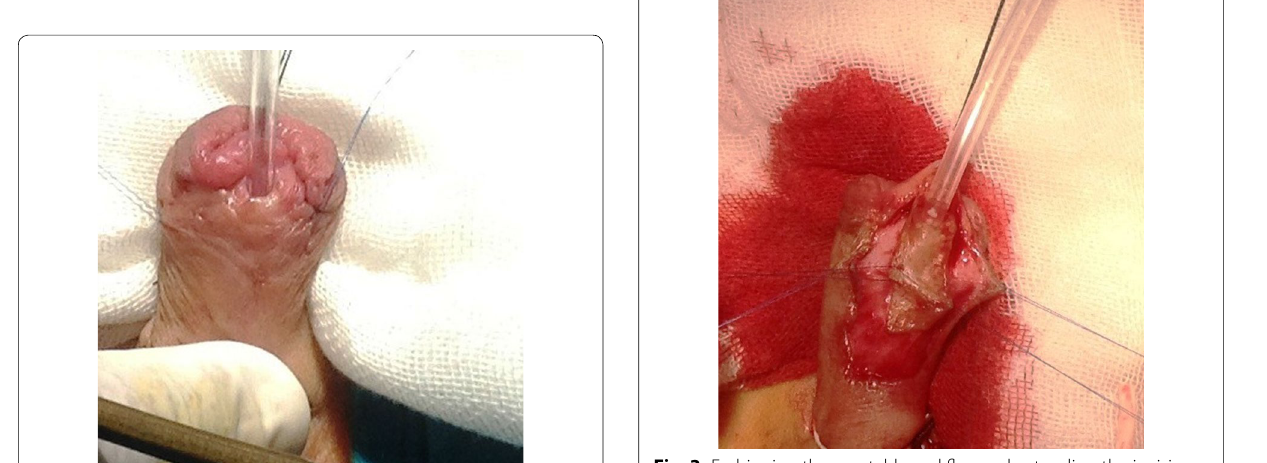
Fig. 3 Fashioning the meatal-based flap and extending the incision till it reaches the urethral